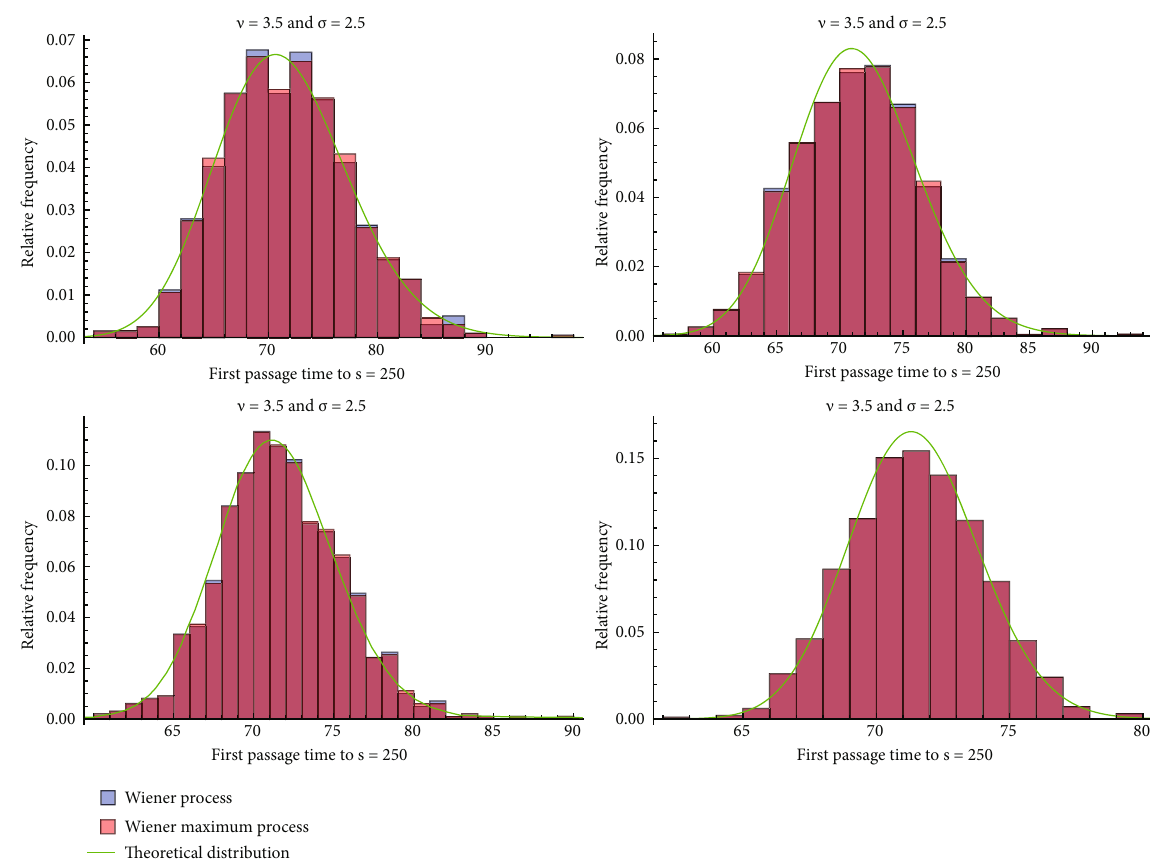
Figure 9: Histograms of Wiener and Wiener maximum process fi rst passage times and theoretical